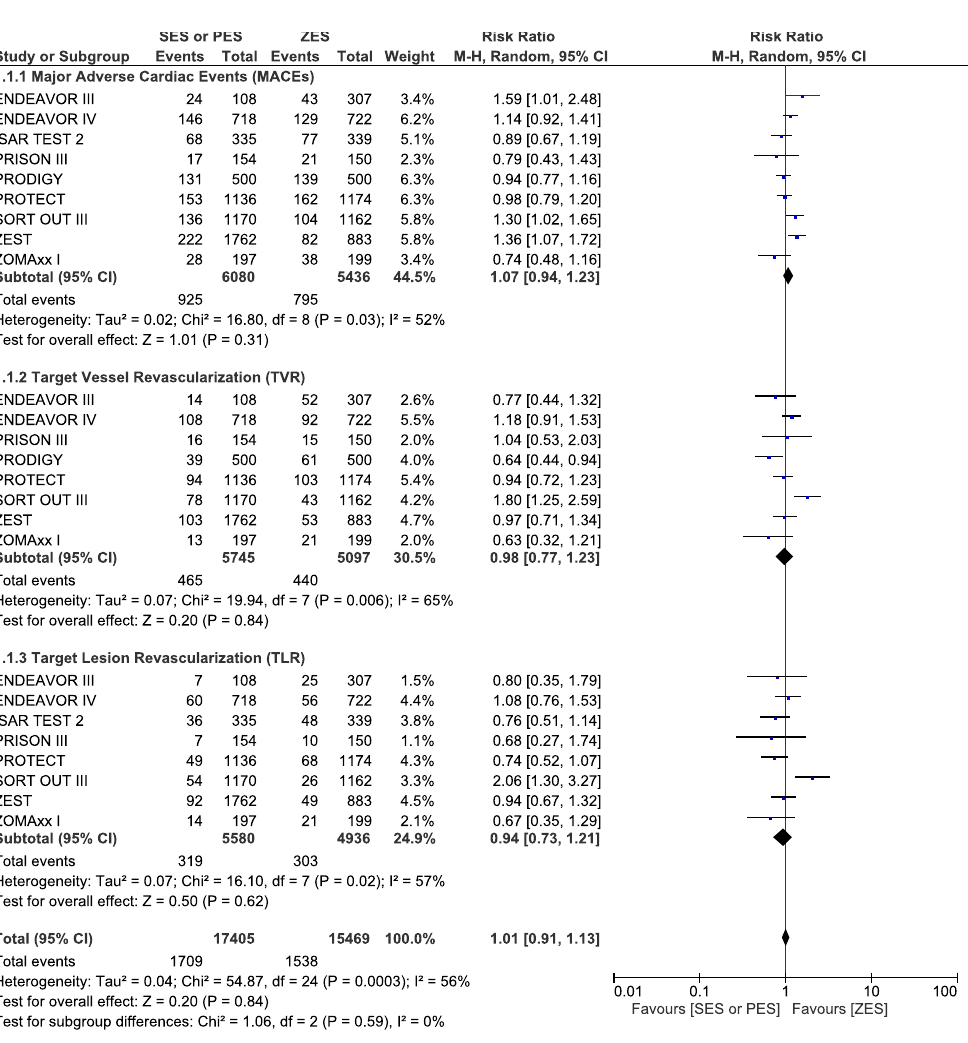
Figure 4. Long term Major adverse events and repeated revascularization which were associated with ZES versus SES or